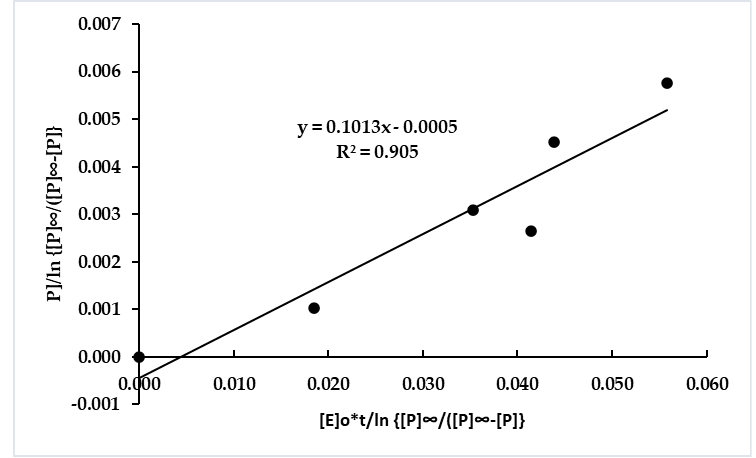
Figure 3. The relationship between [P]/ln{[P] ∞ /([P] ∞ − [P]} and [E]0. t /ln{[P] ∞ /([P] ∞ − [P]} at an enzyme concentration of 15%.